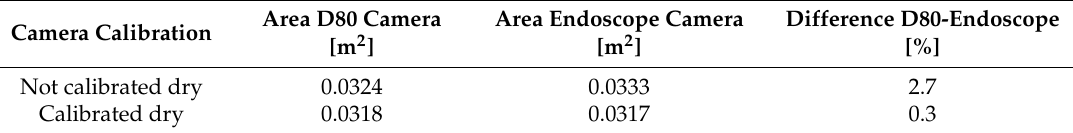
Table 2. Bush area dry condition.